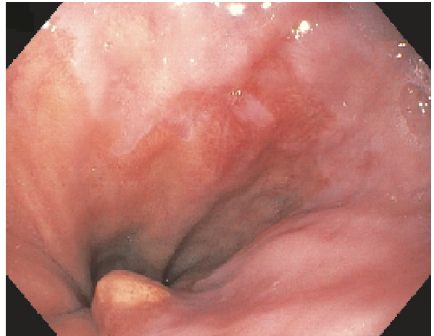
Figure 1: EGD showing a polyp (nodule) at the 𝑧 -line.